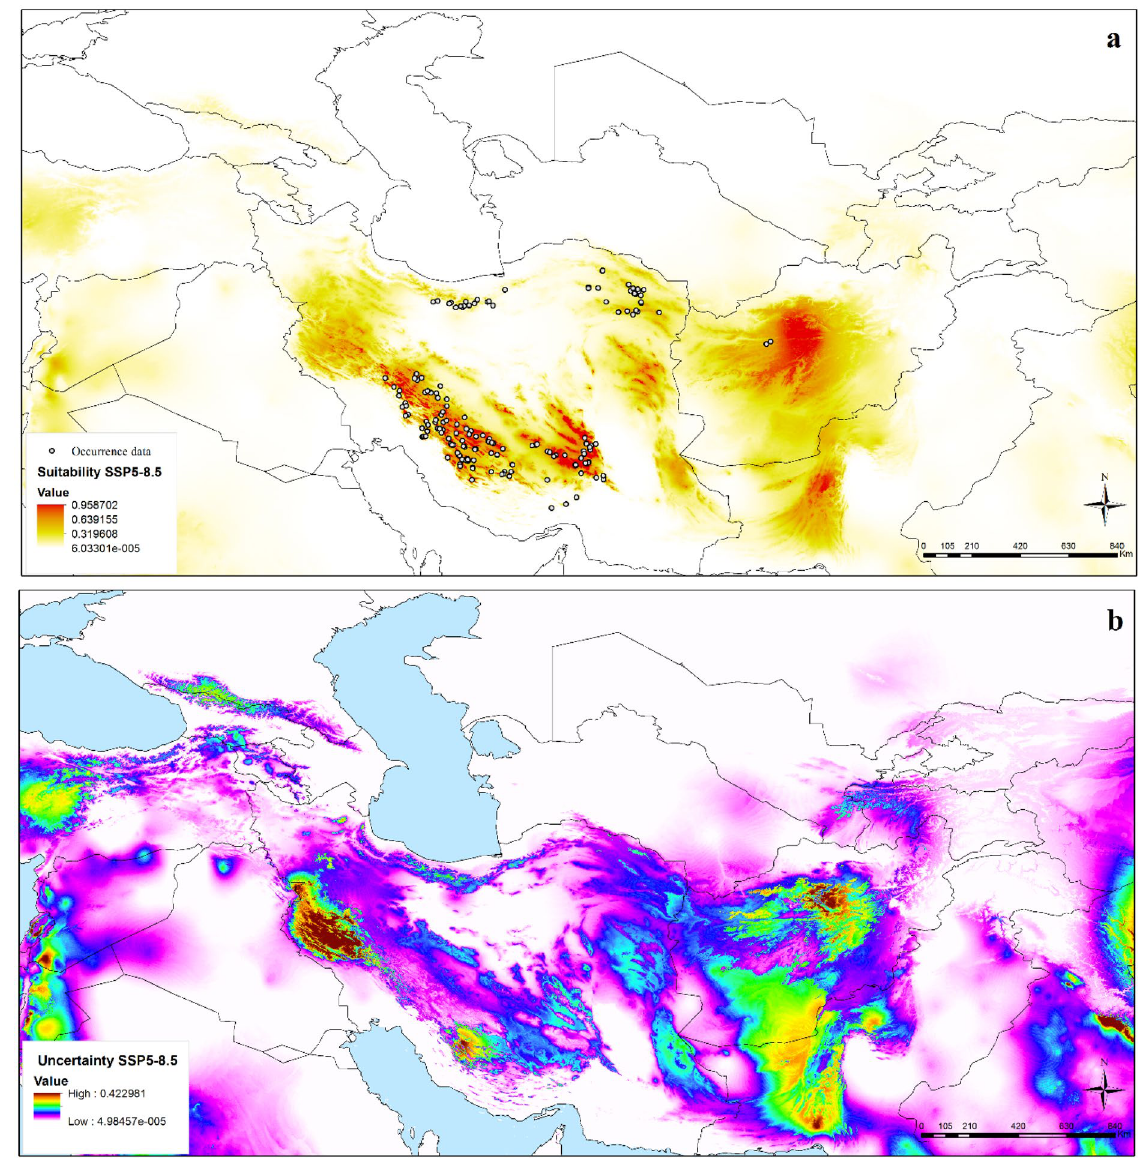
Figure 5. Potential future distribution of Nepeta glomerulosa under Shared Socioeconomic Pathways (SSP5-8.5) across the southwestern and central Asia: ( a ) median prediction, ( b ) uncertainty map (ArcGIS version 10.3.1; http:// www. esri.